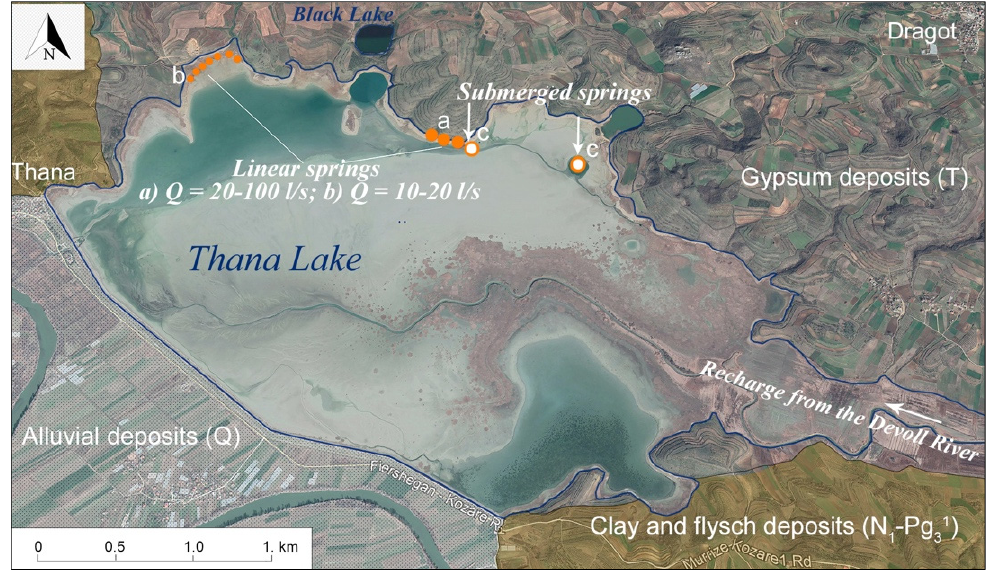
Figure 4. Topographic map of Dumre plateau, marked with the red line.